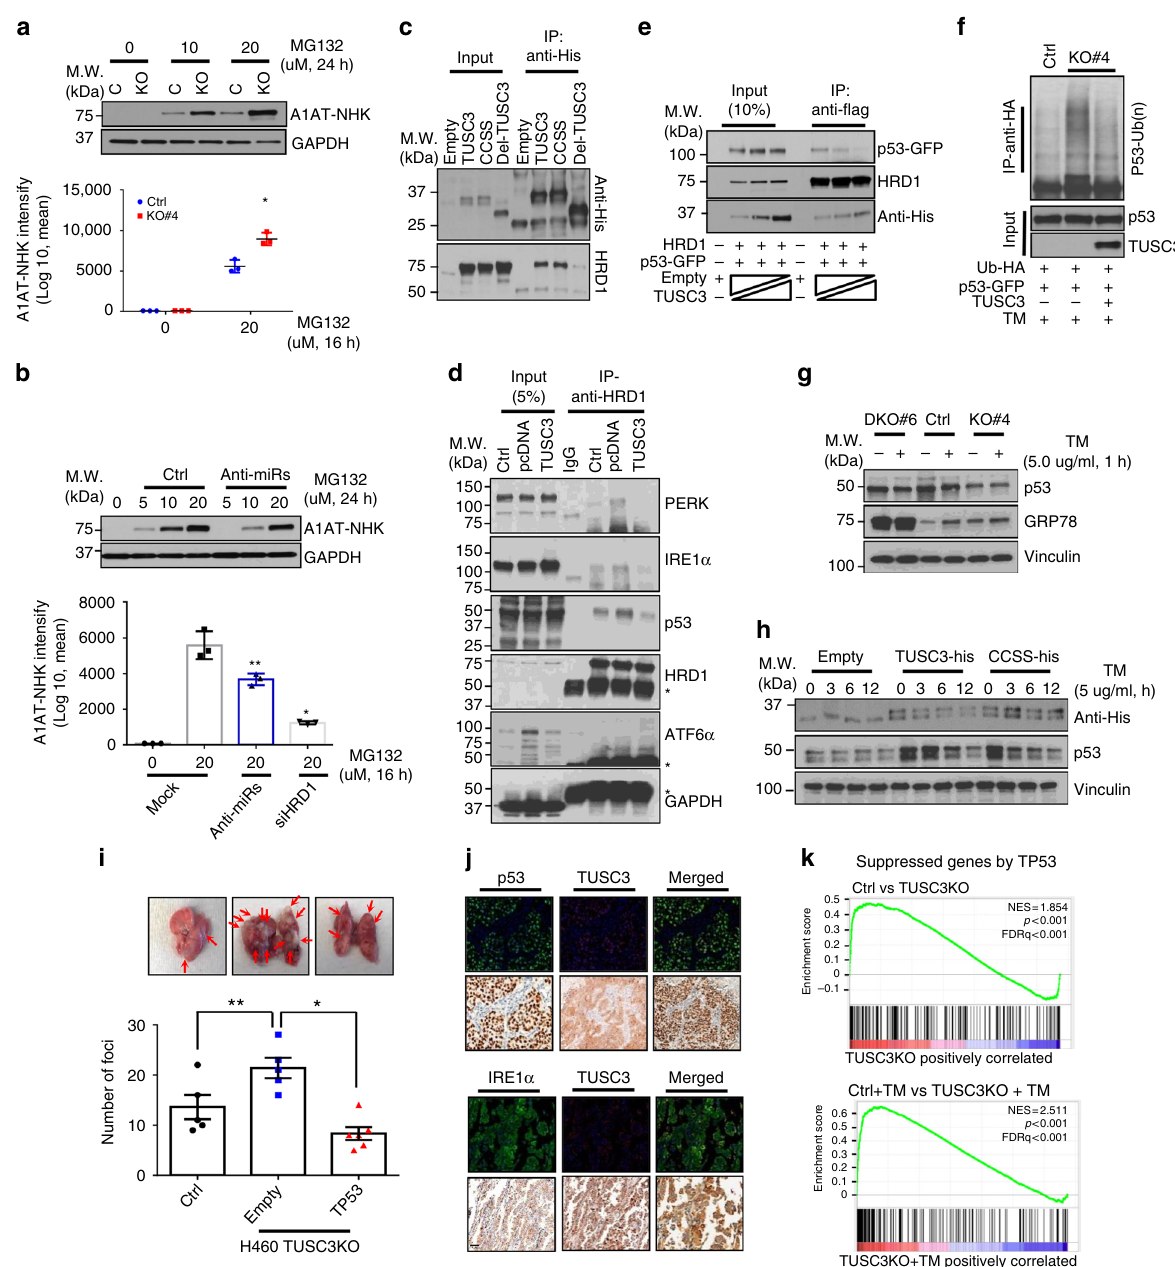
Fig. 4 TUSC3 de fi ciency enhances HRD1-dependent pro-metastatic property by enhancing ERAD activity. a Enhanced A1AT-NHK-ddVenus GFP accumulation in A549 TUSC3KO cells. The A1AT-NHK-ddVenus stable A549 control (Ctrl) or TUSC3 KO cells were generated by transduction with pLL-Lenti-A1AT-NHK-ddVenus virus. The protein accumulation was monitored after incubating the cells with MG132 (20 uM) for 16 h. The accumulation was quanti fi ed by FACS analyses (lower panel) or Western blot analyses using anti-GFP antibody (upper panel). b Decreased accumulation of A1AT- NHK-ddVenus by miR-224 and -520c suppression. Bars indicate means ±SD ( n = 3) and p -values were obtained by two-tailed student t -test ( a and b , * p < 0.001, ** p < 0.02). c Co-immunoprecipitation assays with TUSC3 and HRD1 proteins. pcDNA-TUSC3-V5-His or its mutants (TUSC3-CCSS and Del- TUSC3) was co-transfected with pCMV6-HRD1-Flag in HEK293 cells. d The changed af fi nity of HRD1 protein to its substrates by TUSC3. The endogenous HRD1 protein was precipitated with anti-HRD1 antibody in H460 control, TUSC3 KO or TUSC3-reconstituting TUSC3 KO cells. e In vitro competition assay with p53 and TUSC3 proteins in HEK293 cells. f In vivo ubiquitination assay of p53 protein showing enhanced p53 ubiquitination in response to TUSC3 downmodulation. g Decreased p53 protein in H460 TUSC3 KO cell and rescued in HRD1/TUSC3 DKO cells. The indicated cells were exposed by 5.0 ug/ml of TM for 1 h and subject to Western blot analysis. h Rescued p53 protein in TUSC3 or TUSC3-CCSS mutant expressing H460 TUSC3 KO cells. i Re-suppressed colonization effect of TUSC3KO cells upon TP53 reconstitution. Tail-vein injection was performed using the indicated cells, and subsequently the lung tissues were harvested after 4 weeks. p -values were obtained by student t-test (* p = 0.00031, ** p < 0.038). j Co-expression analyses between TUSC3 and p53 (upper panels) or IRE1 α (lower panels) in lung cancer patient samples. The p53 and IRE1 α are shown in fl uorescence green whereas TUSC3 is shown in fl uorescence red. Scale bar indicates 150 µ m. k GSEA plots indicating gene sets suppressed by TP53 were enriched in TUSC3KO cells either DMSO or TM treatment compared to the